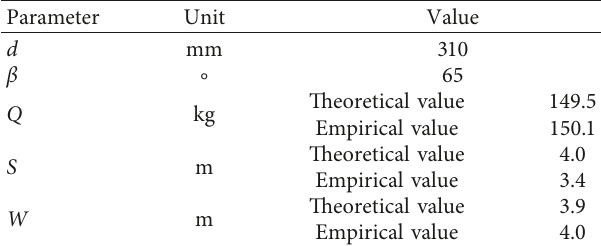
Table 3: Presplit blasting parameters.